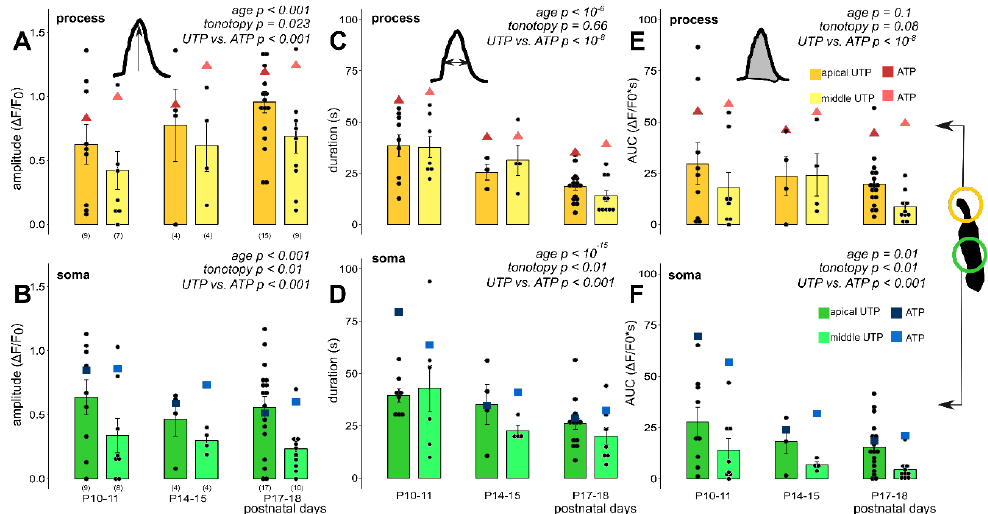
Figure 5. Exogenous UTP (100 µM in perfusion), a selective P2Y agonist, evoked developmental